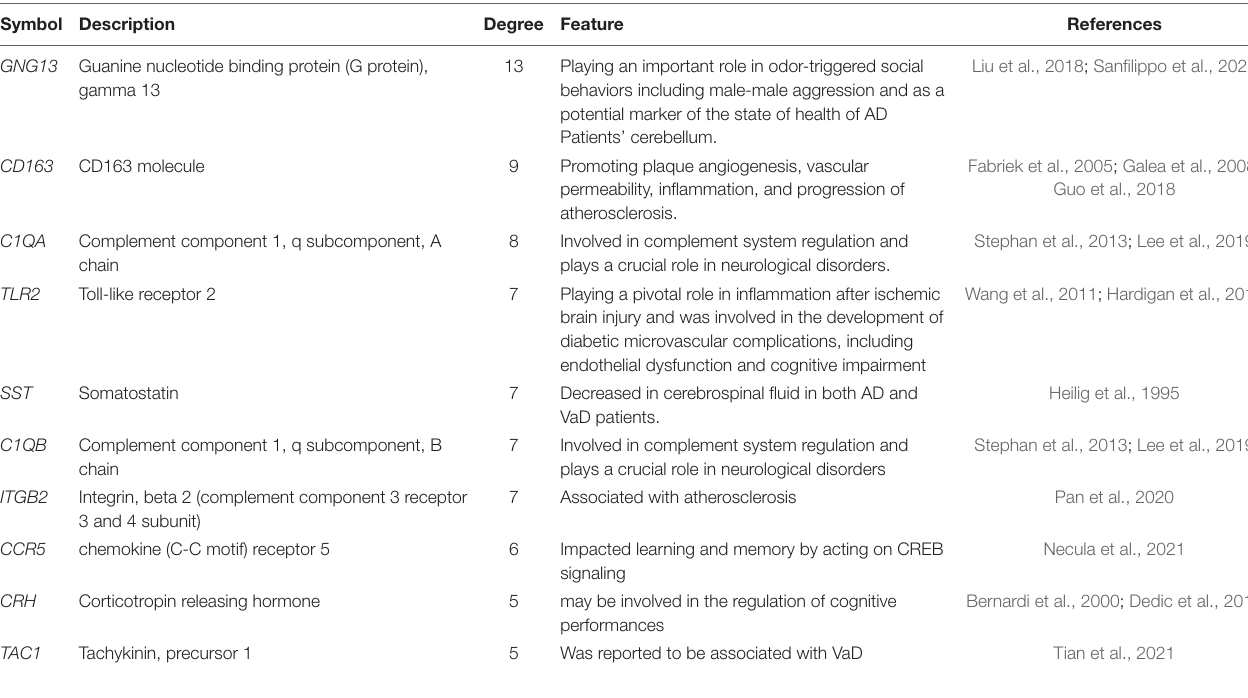
TABLE 4 | Ten hub genes identified in the protein–protein interaction network of proteins encoded by the overlapping differentially expressed genes in vascular